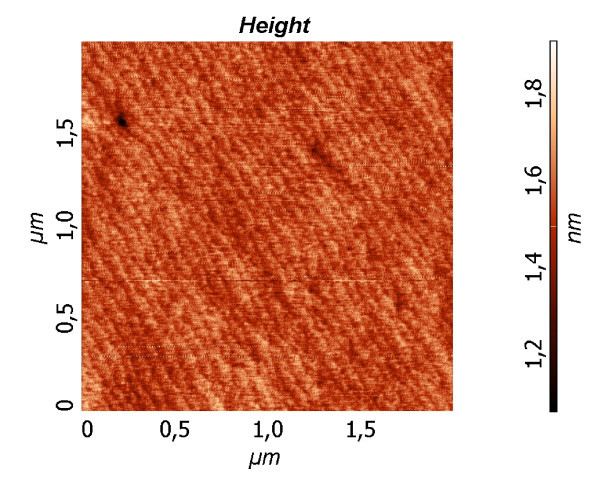
AFM image from wetting layer Ge0.96Sn0.04 with 0.33 nm thickness, grown at 350°C.